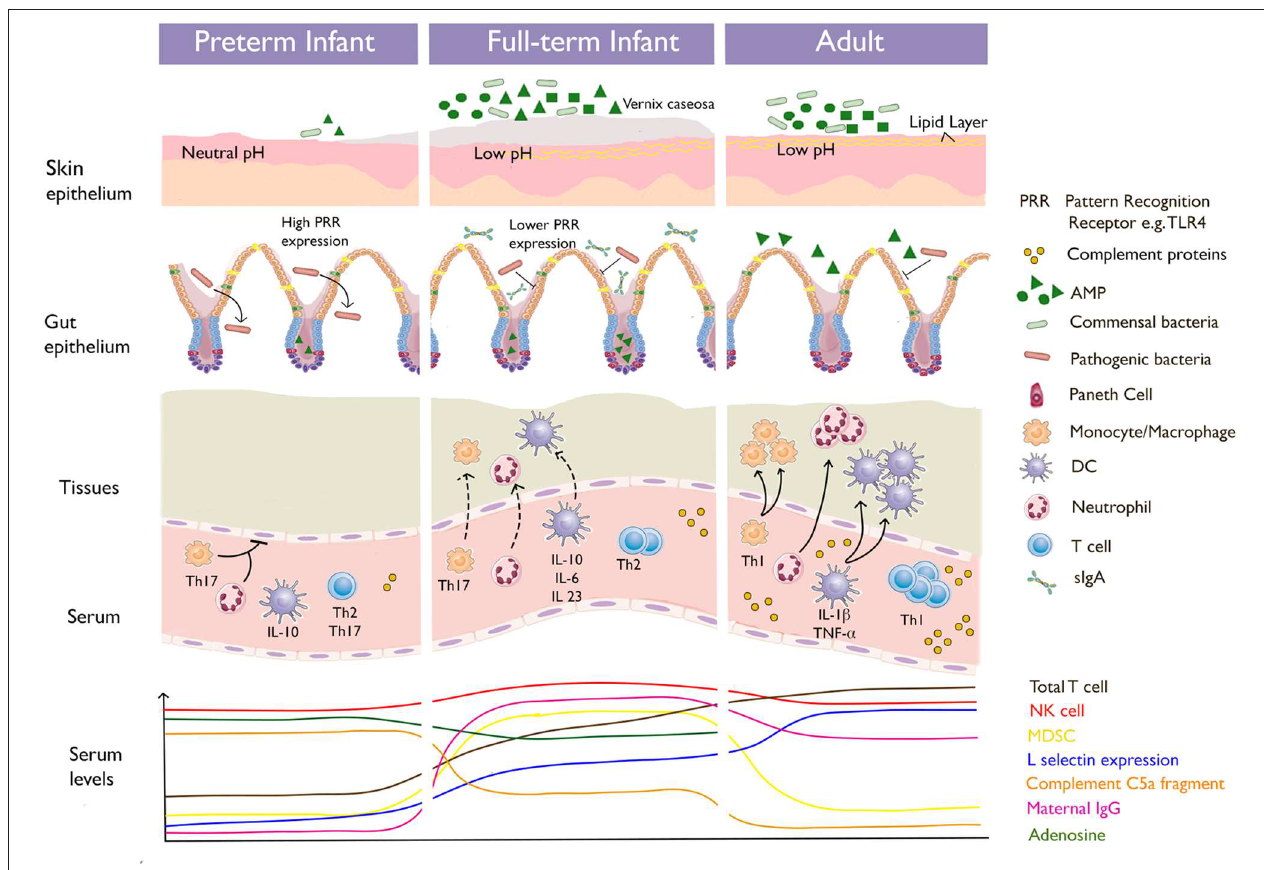
FIGURE 1 | Diagrammatic overview of immune factors at their anatomic sites, illustrating how they interplay.